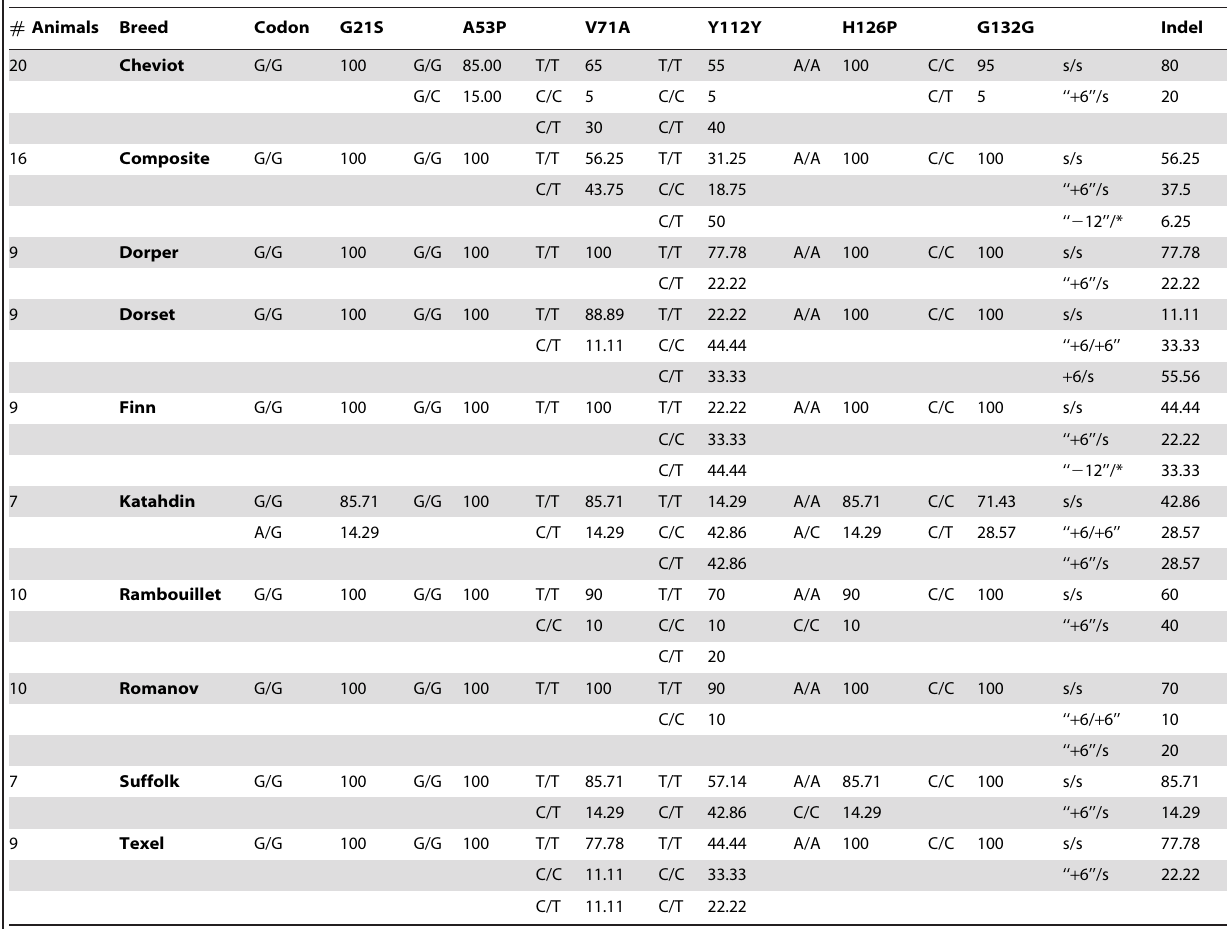
Table 2. Polymorphisms by sheep